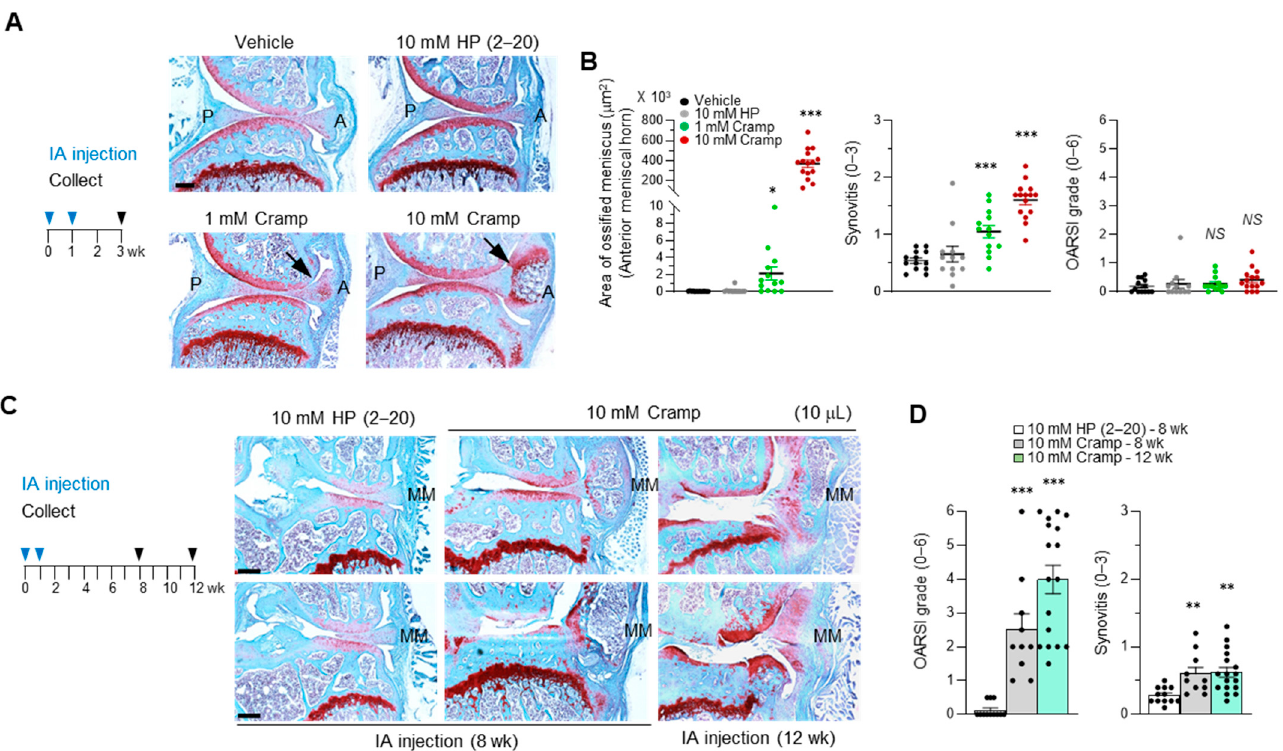
Figure 6. IA injection of Cramp at high concentrations results in ossification and tear of the meniscus and cartilage destruction. ( A , B ) 12-week-old male mice were subjected to IA injection with 10 μ L of vehicle ( n = 13), 10 mM control HP (2–20) peptide ( n = 12), 1 mM Cramp ( n = 13) or 10 mM Cramp ( n = 15) for 3 weeks. ( A ) Safranin-O staining of cartilage sections. Arrows indicate the region of meniscal ossification. P, posterior meniscal horn; A, anterior meniscal horn. Bars = 200 μ m. ( B ) Measurement of ossified region in anterior meniscal horn or scoring of synovitis and OARSI grade. Values are the means ± SEM. * p < 0.05, *** p < 0.001 versus vehicle-treated group. NS , not significant. ( C , D ) 12-week-old male mice were treated with 10 μ L of 10 mM control HP (2–20) peptide or Cramp. Mice were harvested at 8 or 12 weeks after first IA injection. Representative images of safranin-O staining ( C ) and scoring of OARSI grade and synovitis ( D ) are shown. MM, medial meniscus. Bars = 200 μ m. Values are the means ± SEM. n = 12 for 10 mM HP (2–20) 8wk, n = 10 for 10 mM Cramp 8wk and n = 17 for 10 mM Cramp 12wk. ** p < 0.01, *** p < 0.001 versus control HP (2–20) peptide-treated group.